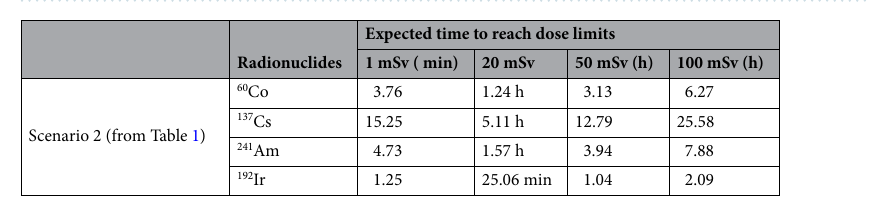
Table 2. Expected time to reach various dose limits. The expected times were derived from the dose rates at a distance of 10 cm from the patient.